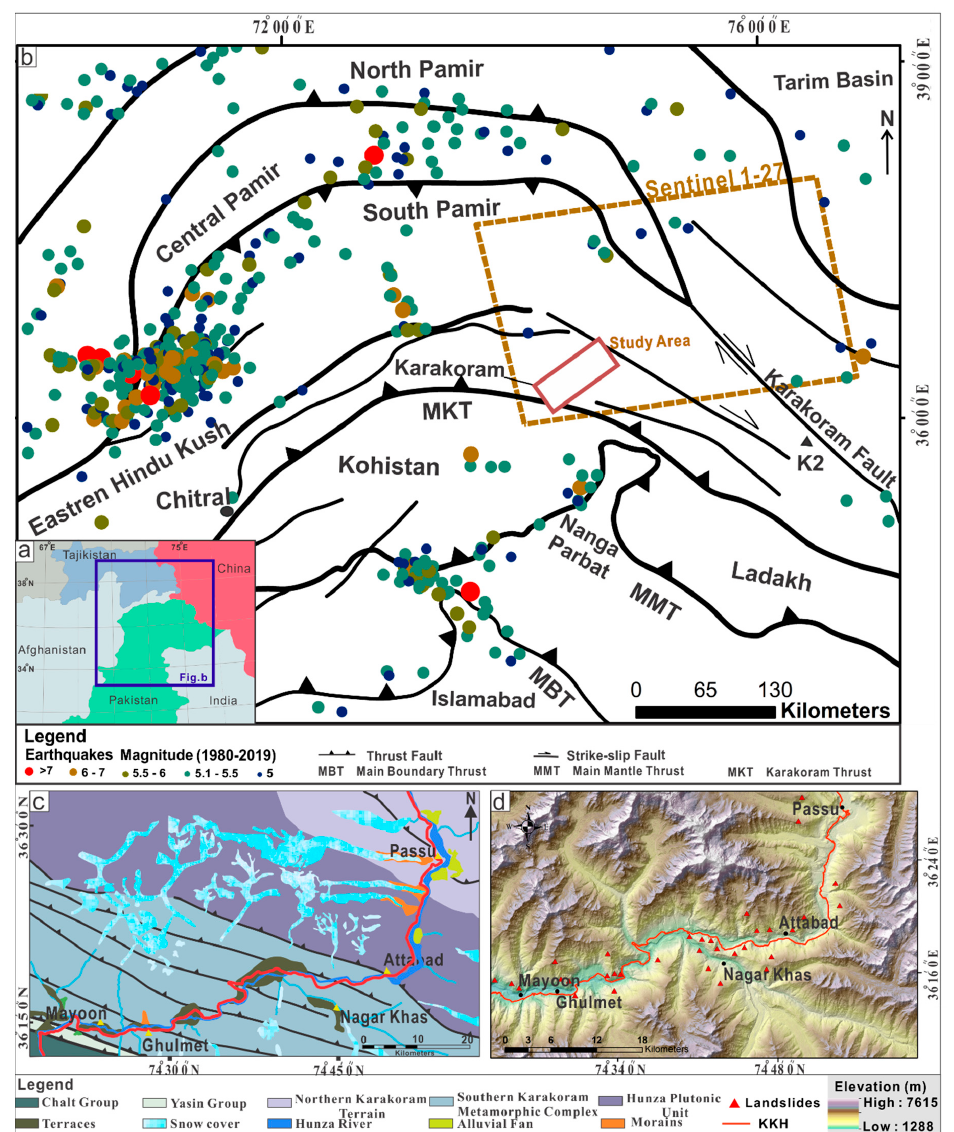
Figure 1. Overview of geological setting of the study area. (a) Location of the study area in the region, (b) regional tectonic map of north Pakistan showing active faults and major earthquake events in the region (USGS Earthquake Catalog, 2019), (c) geological map of the study area (modified from Searle, 1999 [12] ), and (d) digital elevation model of a part of Hunza-Nagar area.